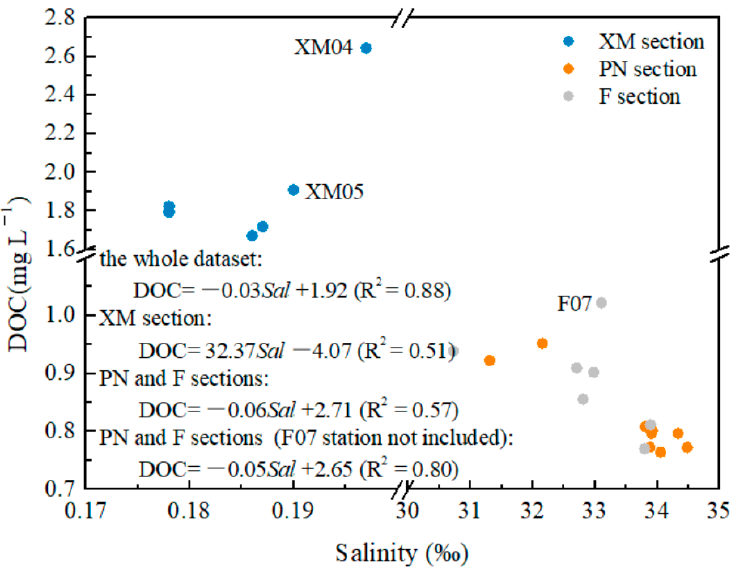
Figure 2. Relationship between the dissolved organic carbon (DOC) and salinity. Distinct positive correlations were observed for the inclusive dataset and the datasets of the respective three sections, even though there was no medium salinity dataset.